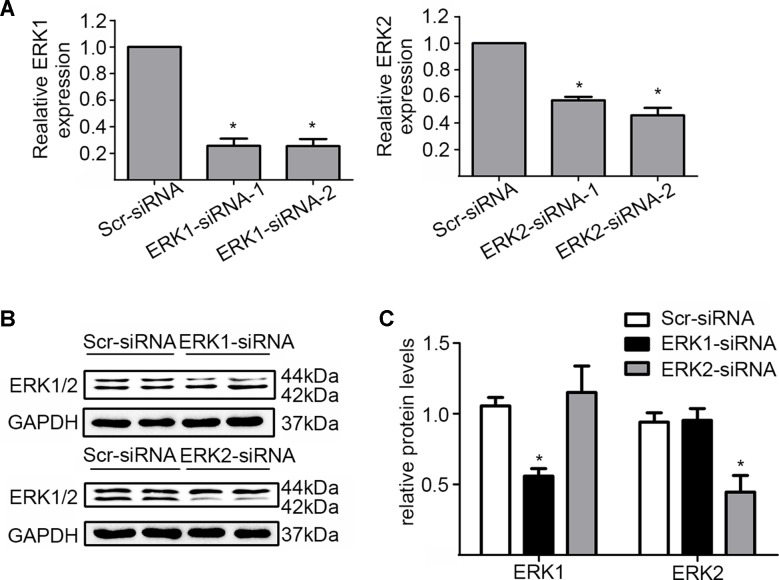
Knock-down of ERK1 or ERK2. (A) ERK1 or ERK2 silencing at the mRNA level (n = 3). (B) ERK1 or ERK2 silencing at the protein level (n = 3). (C) Quantitative results of ERK1 or ERK2 proteins (n = 3). The data were analyzed by ANOVA and expressed as the mean ± SEM. *P < 0.05, compared with Scr-siRNA.